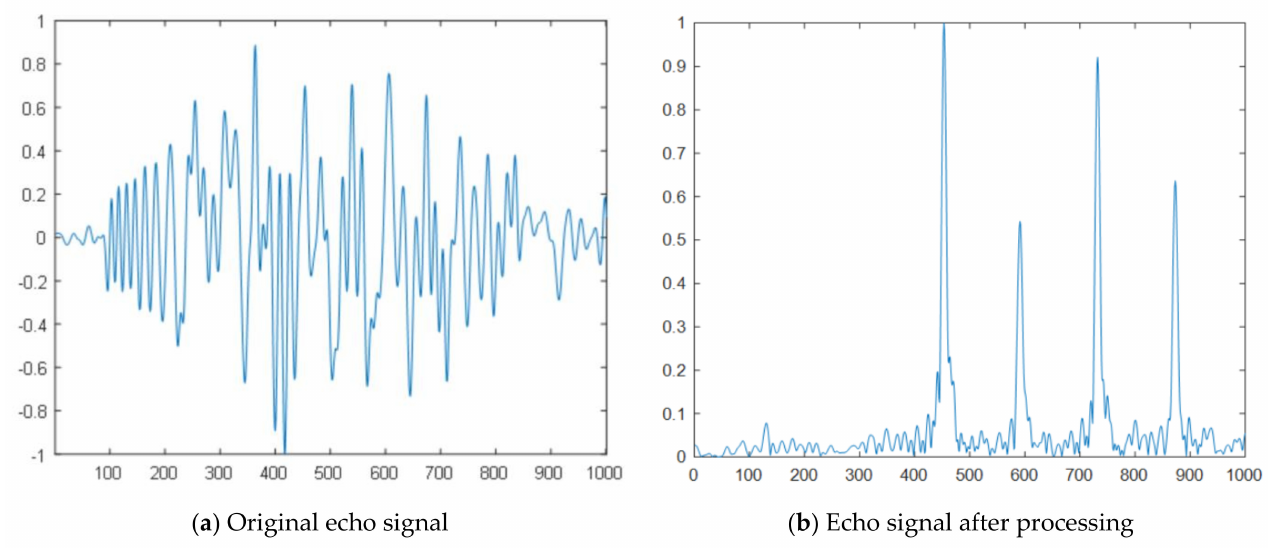
Figure 4. Echo signal before and after processing.